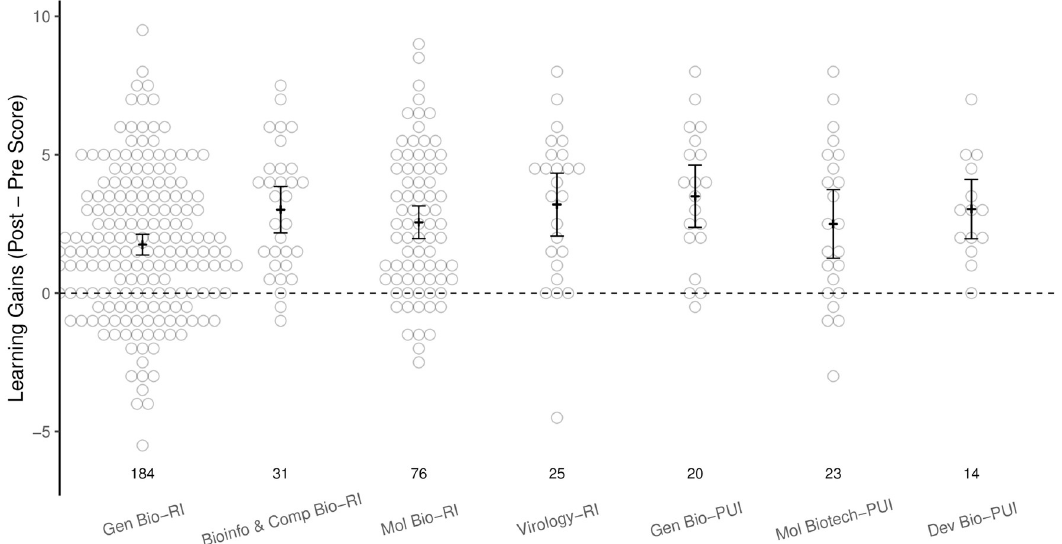
Fig 3. Learning gains from matched pre-/post-assessment quiz scores disaggregated by course type. Courses at PUIs in which the modules were implemented included General Biology, Molecular Biotechnology, and Developmental Biology. All others, including an additional General Biology course were at RI institutions. Means are represented by a narrow black crossbar. Black error bars represent the 95% confidence interval of the mean. The black dashed line indicates a pre-/post- difference of zero, indicating neither a learning gain nor loss. Learning gains significantly greater than 0 were observed in all classes (adj. p < 0.001, one-sample t-test). Sample size (n) for each course is shown above course